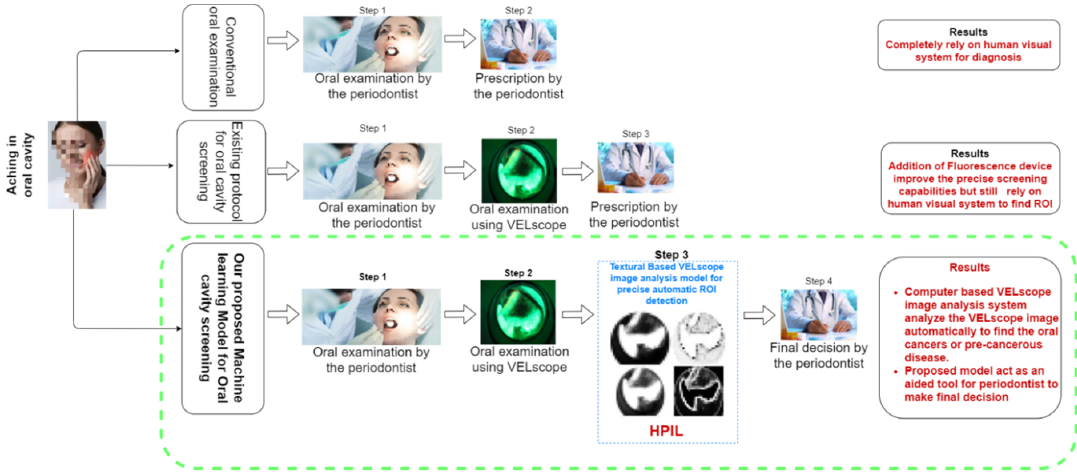
Figure 3. The Healthcare Professional in the loop (HPIL) workflow.